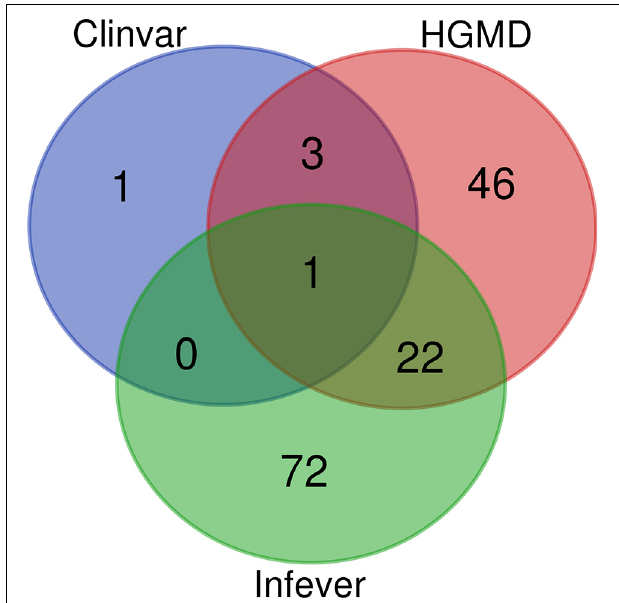
FIGURE 1 | Venn Diagram for the variants present in HGMD, ClinVar, and